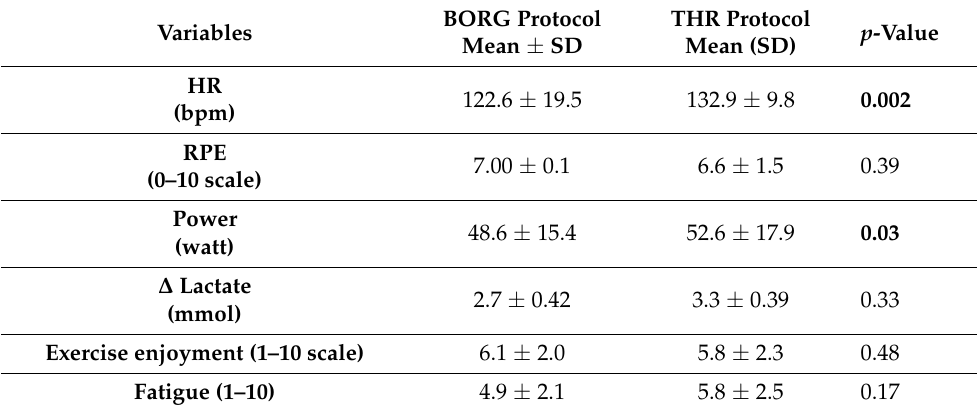
Table 1. Exercise variables and statistical differences between THR and BORG